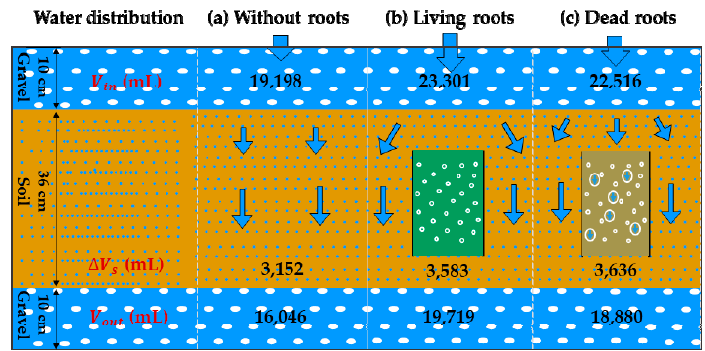
Figure 2. Water distribution and water flow in soil without or with living and dead roots.